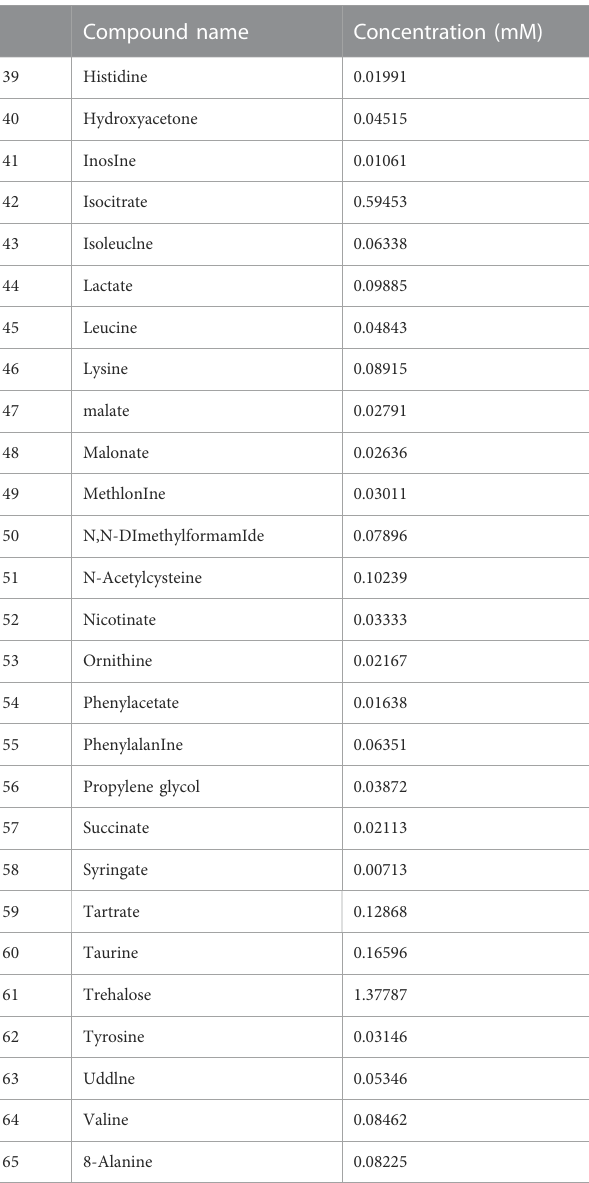
TABLE 1 Metabolite composition of AME-1 as analyzed by